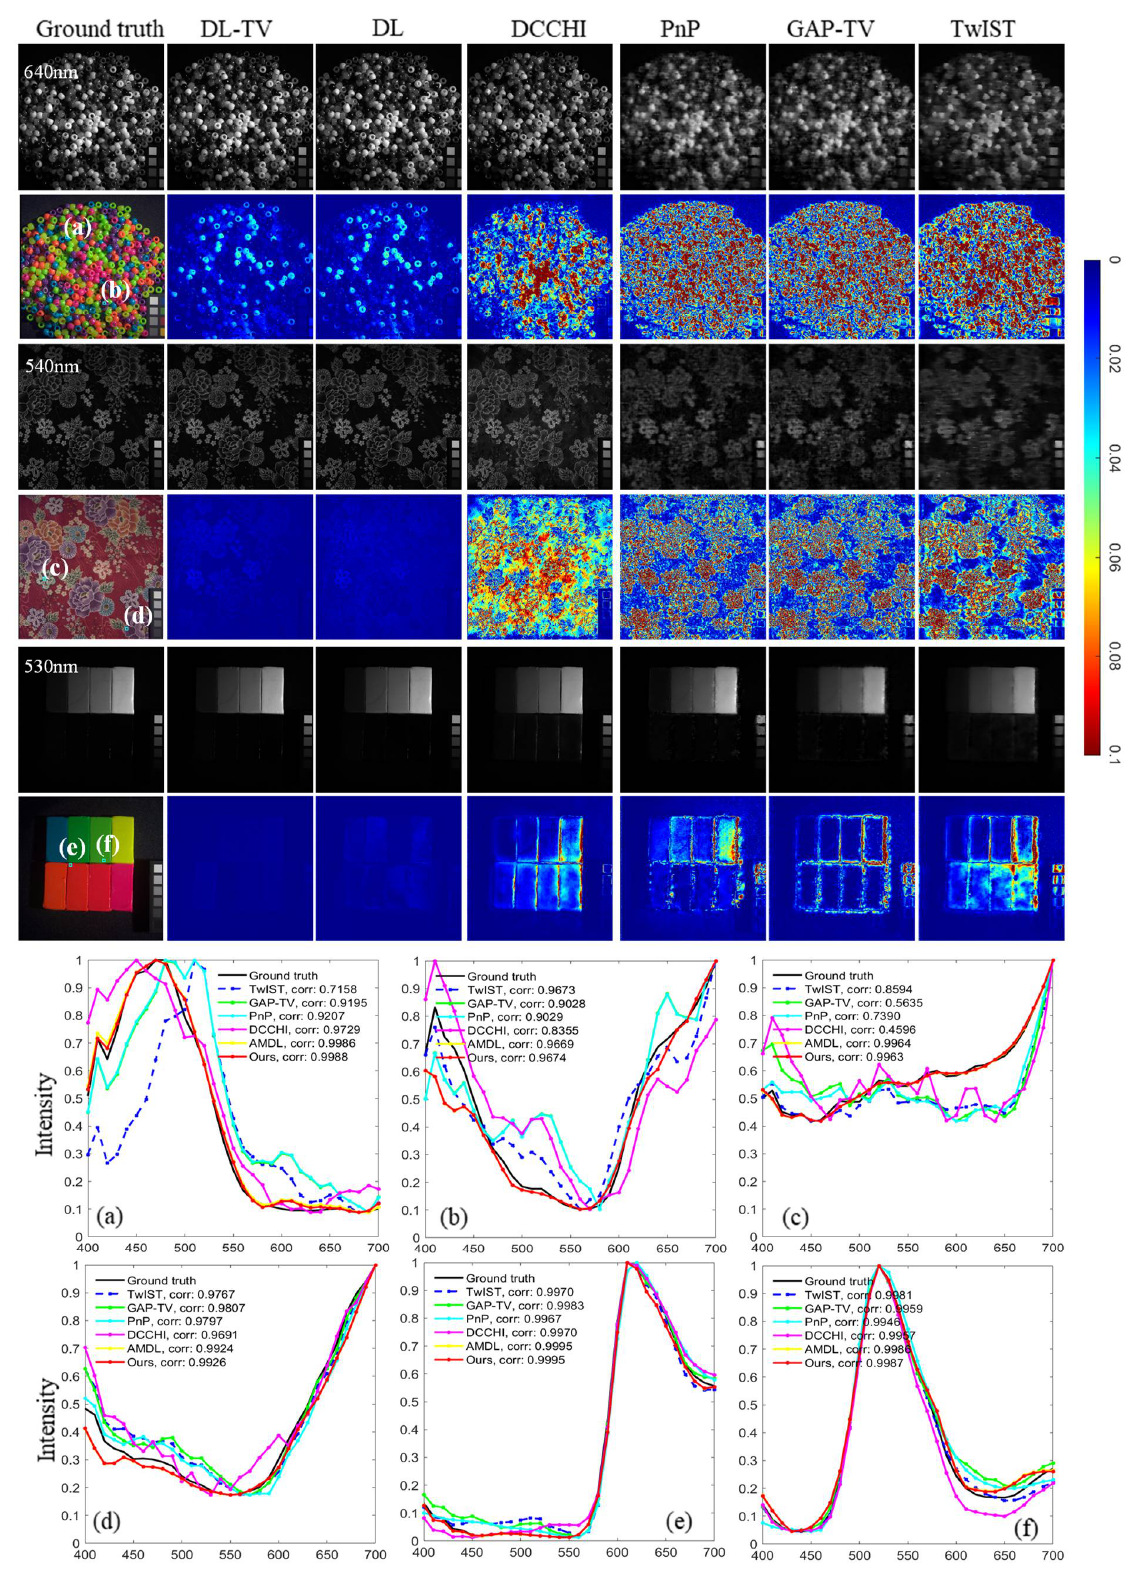
Figure 3. Simulation results calculated using three different MSIs of the CAVE dataset. The first, third, and fifth columns show the simulation results of “beads,” “cloth,” and “clay” MSIs. Error maps are shown in columns 2, 4, and 6 for comparison. To compare with the ground truth, the spectral curves of selected regions are shown in ( a – f ).